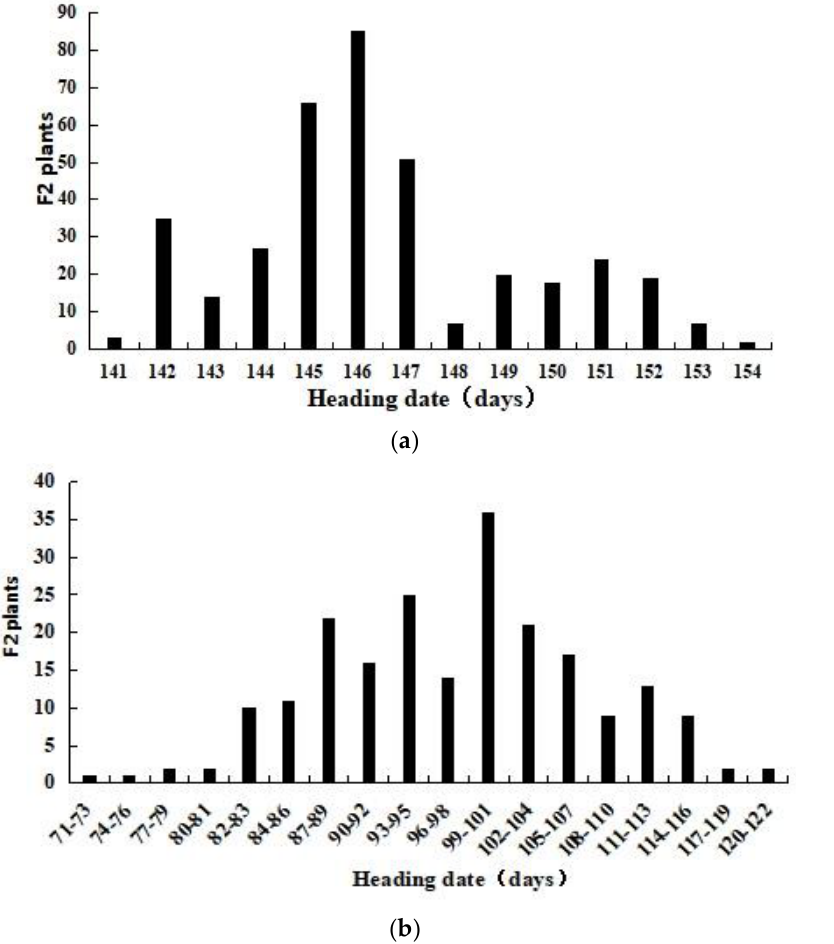
Figure 7. Frequency of the plants with different heading dates in the (CASL7BS × CS) F 2 populations grown in the field during 2016 – 2017 named as P 1 ( a ) and in the growth room named as P 2 in 2017 ( b ). Table 1. Young spike development process of CASL7BS and Chinese Spring (CS).